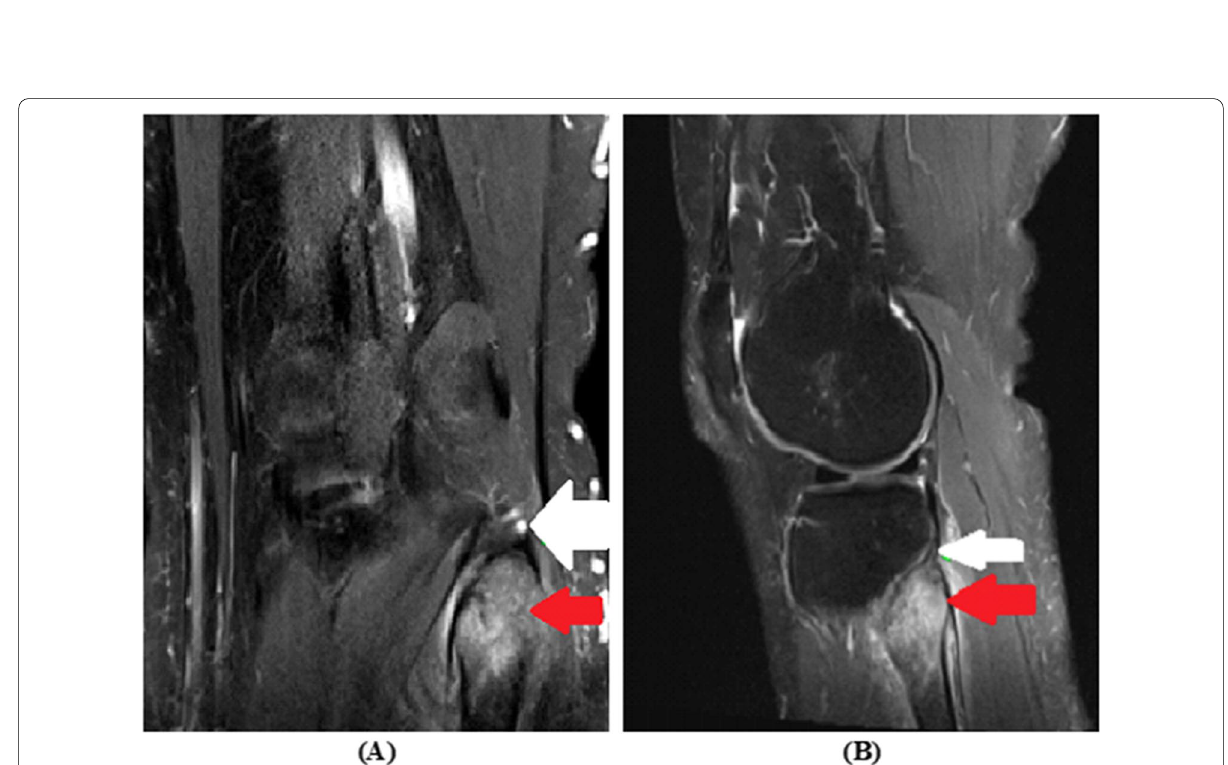
Fig. 3 A 43‑year‑old female patient suffering from instability and pain of the left knee following recent trauma by direct force applied to the knee. Sagittal and coronal PDFS images ( A , B ) showing marrow contusions of the fibular head suggestive of arcuate fracture (red arrow) with partial tear of the popliteofibular ligament (white